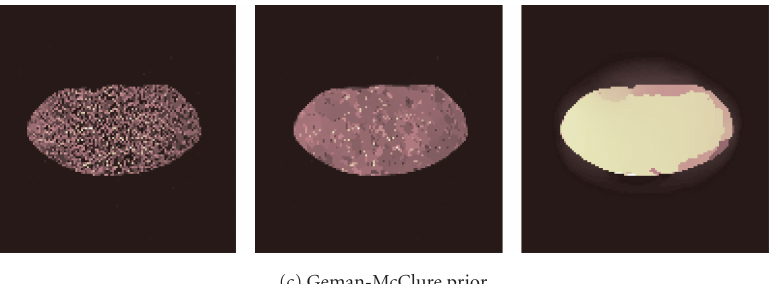
Figure 5: Reconstructed images of one noisy data set with the lumpy background shown in Figure 3(c). The three images in each group are reconstructed with di ff erent β